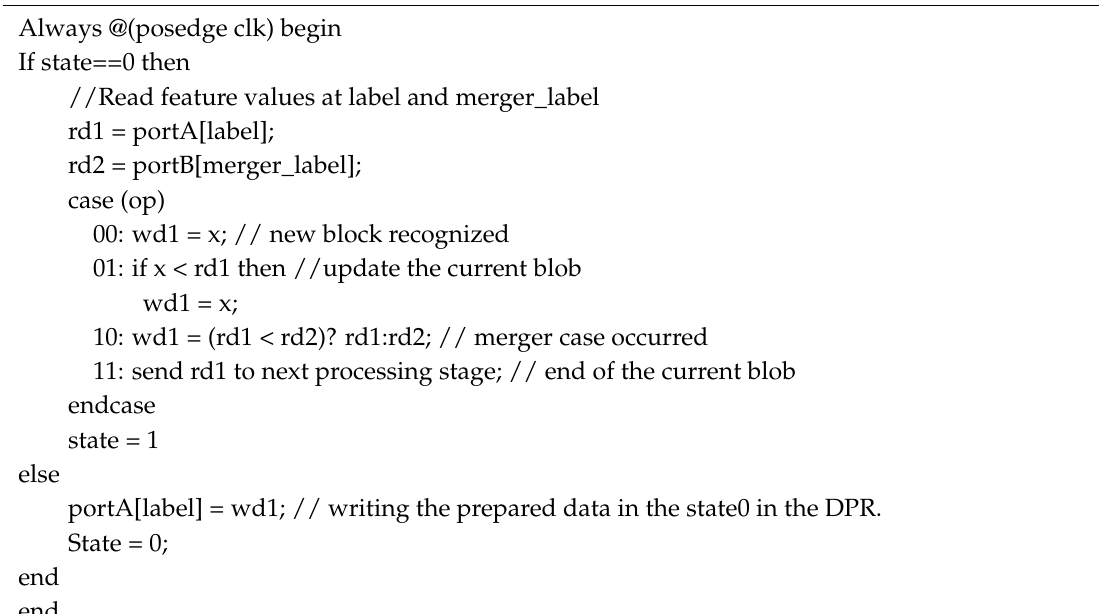
Algorithm 1. Pseudo code for updating xmin/ymin